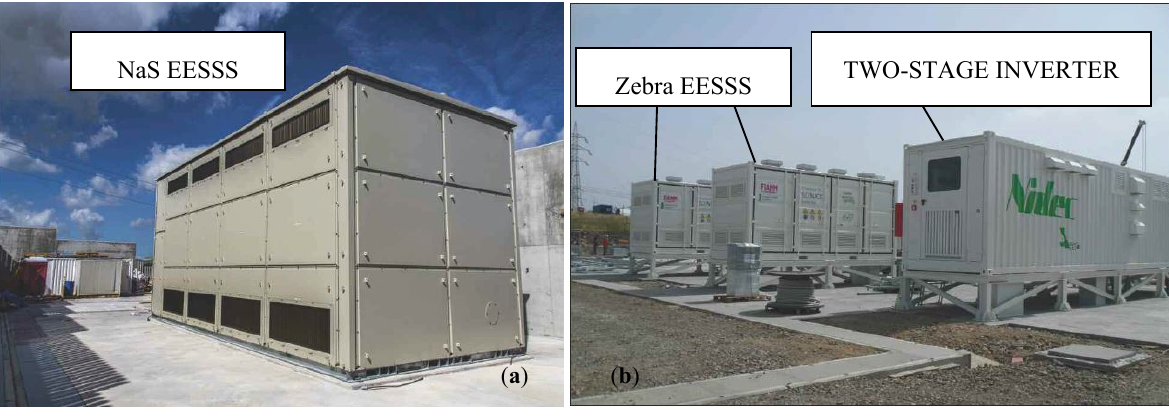
Figure 16. ( a ) Terna Energy intensive EESSS installation in Ginestra, Italy; ( b ) Terna power intensive EESSS installation in Codrongianos, Italy.